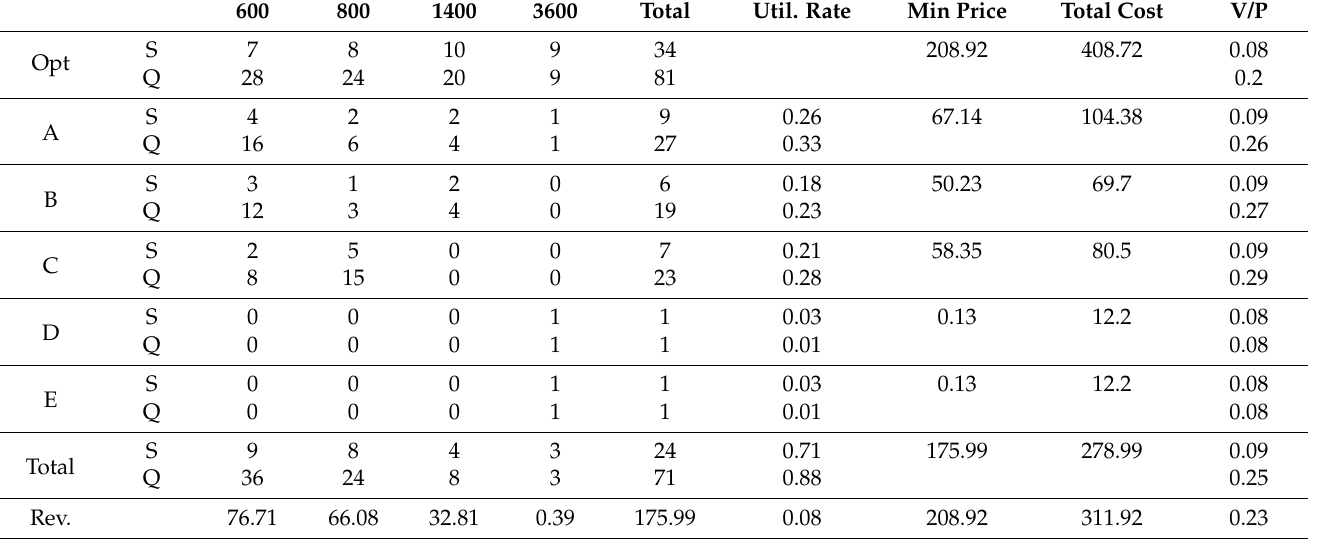
Table 12. Result of GA and